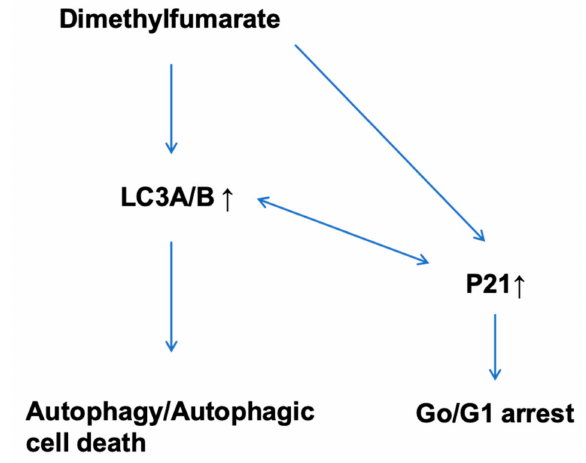
Figure 8. Possible DMF dependent way of regulation in colon carcinoma cell